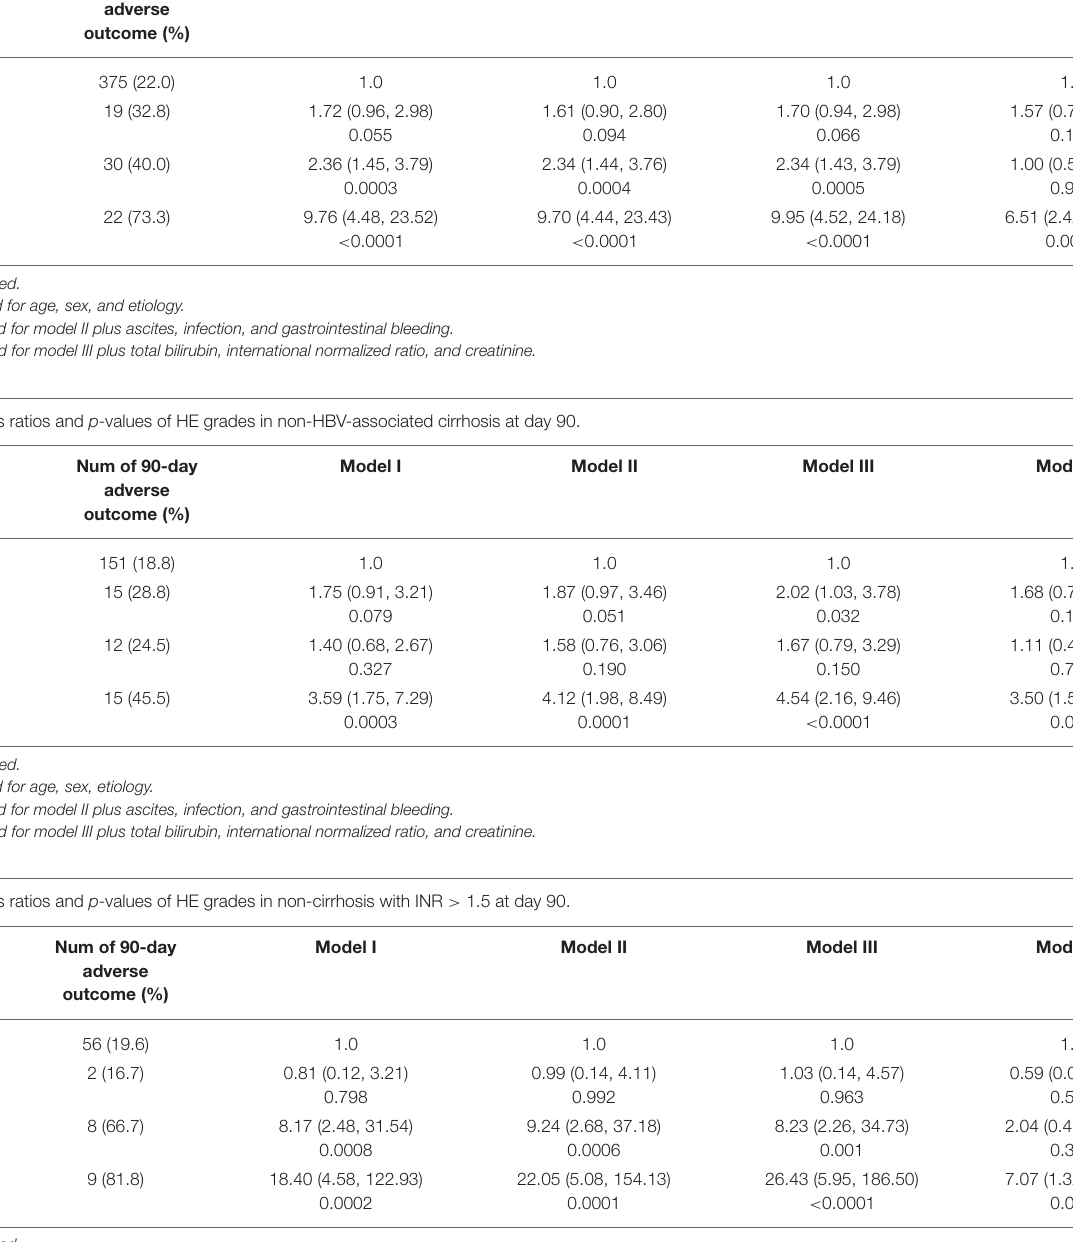
TABLE 6 | Odds ratios and p -values of HE grades in patients with HBV-associated cirrhosis at day 90. HE_GRADE Num of 90-day adverse